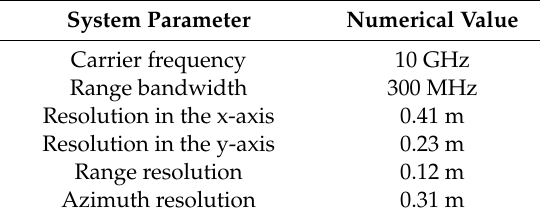
Table 1. Simulation parameters.